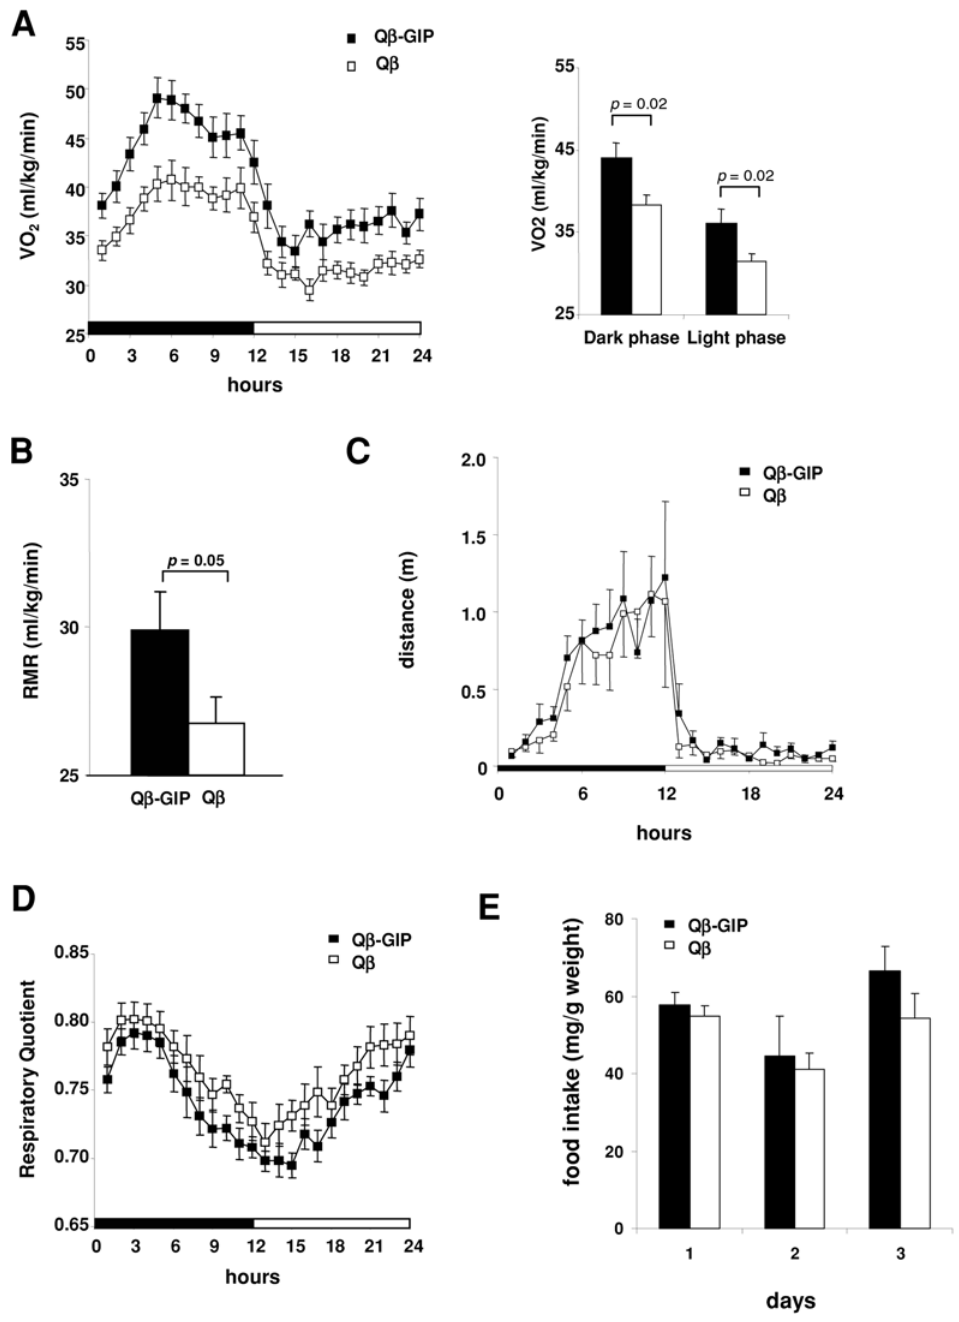
Figure 3. Vaccination against GIP increases energy expenditure and metabolic rate. Indirect calorimetry in immunized mice. Female mice were immunized (days 0, 14, 28, 42 and 125) with Q b -GIP (n=8) or Q b VLPs (n=10) and placed on a high fat diet. Indirect calorimetry was performed on half of the group on day 128 and on the other half on day 139. Combined data from these measurements are shown. (A) Oxygen consumption (VO2). The left panel shows average oxygen consumption + / 2 SEM. Q b -GIP-vaccinated animals display statistically, significantly increased VO2 (p , 0.0001) over the 24 h period. Average oxygen consumption + / 2 SEM during the dark and light phase is shown on the right. VO2 was significantly increased in Q b -GIP-vaccinated animals compared to Q b controls in both the dark (p=0.02) and light phase (p=0.02). (B) Resting metabolic rate (RMR). RMR was increased in Q b -GIP-vaccinated animals compared to Q b VLP controls (p=0.05). (C) Physical activity was determined by measuring beam brakes over a 24 h period. No significant differences were observed between the two experimental groups. (D) Respiratory quotient (RQ) was measured for 24 hours during the dark and light phase. Average RQ 6 SEM is shown. RQ is defined as VCO2 (L)/VO2 (L). The difference observed between the two experimental groups did not reach statistical significance. (E) Food intake. Food intake was monitored over three consecutive day after the energy expenditure experiment. Average daily food intake in mg/g body weight + / 2 SEM (n=5 are shown). No statistically significant difference was observed between the experimental groups (p . 0.05). All statistical analyses were performed by two-sided t-tests.